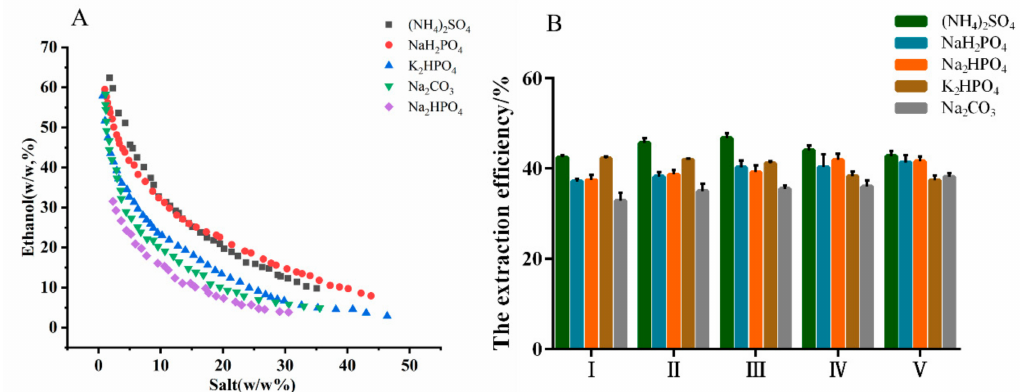
Figure 1. Binodal curves for aqueous two-phase system composed of ethanol/salts at 25 ◦ C, and atmospheric pressure ( A ), and the effect of the compositions of aqueous two-phase system on the extraction efficiency of polysaccharides from Malus hupehensis ( B ): mass fraction of ethanol/salt